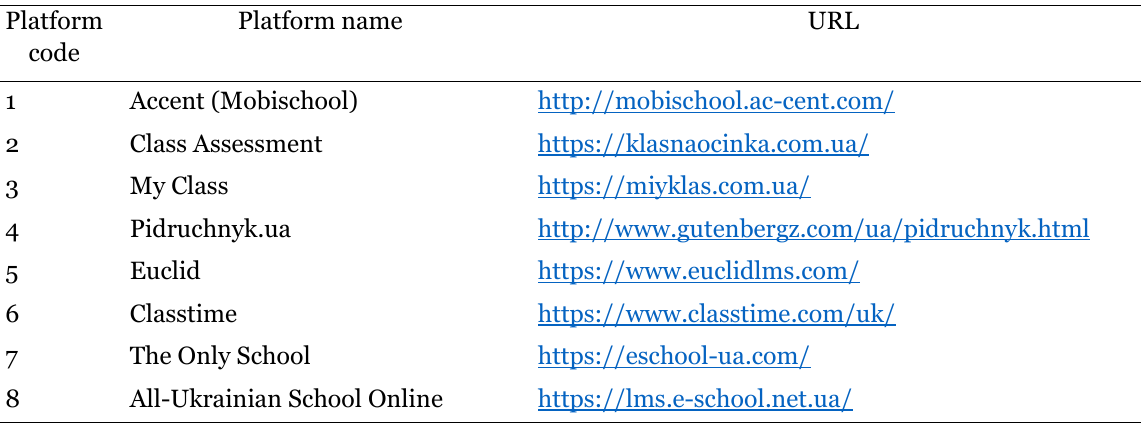
E-learning Platforms of Ukrainian Developers